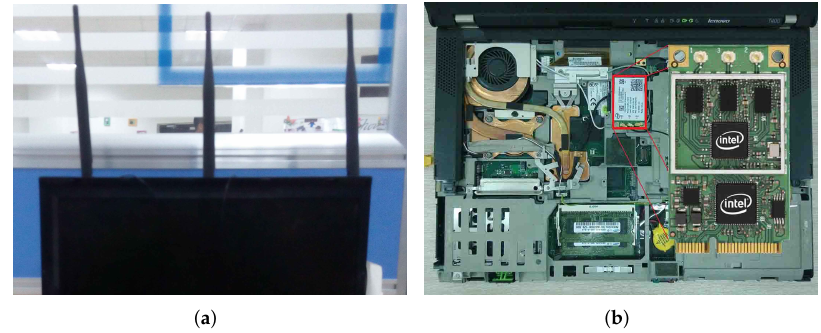
Figure 1. Devices used in the experiments. ( a ) Three antenna receiver. ( b ) Intel 5300